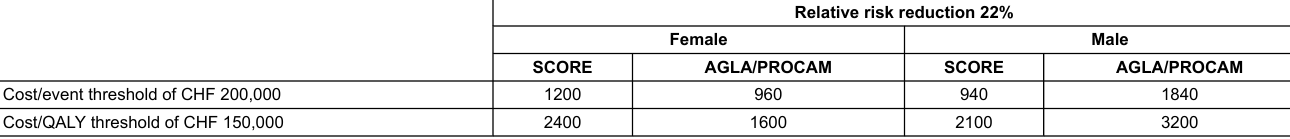
Table 6b: Maximum threshold for cost efficiency in the personalised price (PEP) and the quality adjusted life-year (QALY) models.